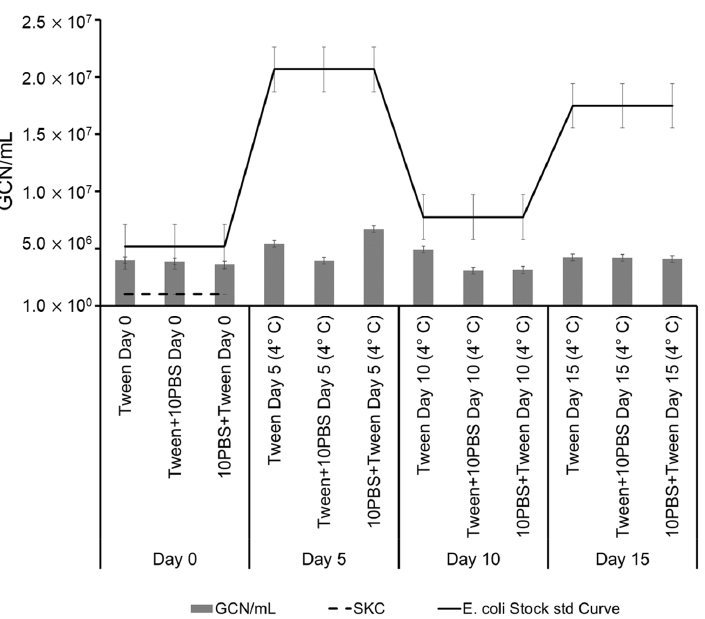
Figure 3. Real-time PCR analysis of the E. coli samples archived for 15 days at 4 °C collected in Tween, amended with 10% PBS (Tween + 10PBS) or being added to 10% PBS (10PBS + Tween). The GCN/mL values for the samples collected on Day 0 with the SKC impinger are indicated with a dashed line. The solid line represents the non-aerosolized E. coli stock.